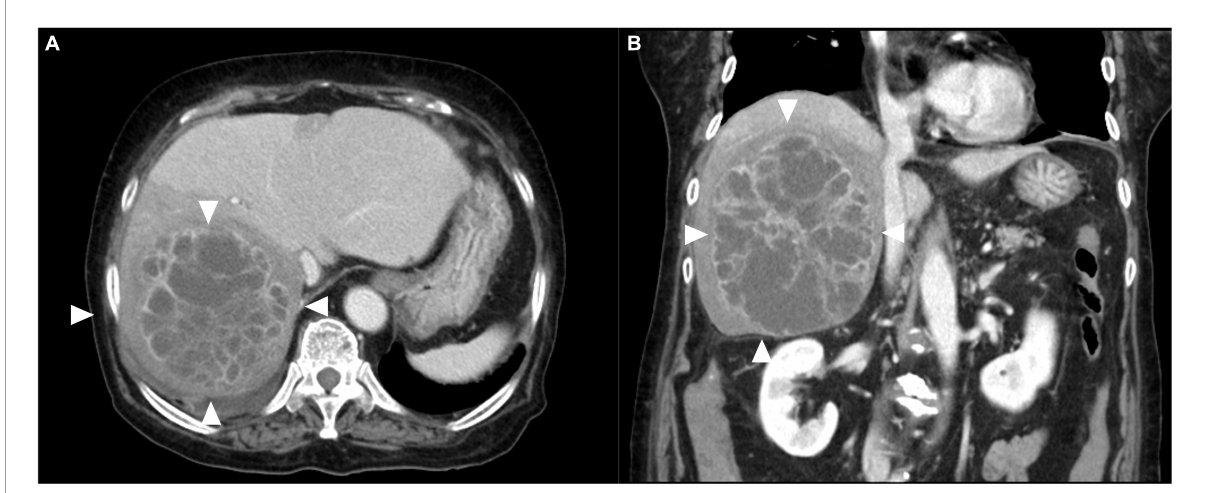
FIGURE1 Contrast-enhanced computed tomography images of the liver. (A) Multiloculated liver abscess (white arrows) occupying the right lobes of the liver extending across the right hepatic vein. (B) Coronal image revealing multiloculated liver abscess (white arrows) 15 cm in diameter.